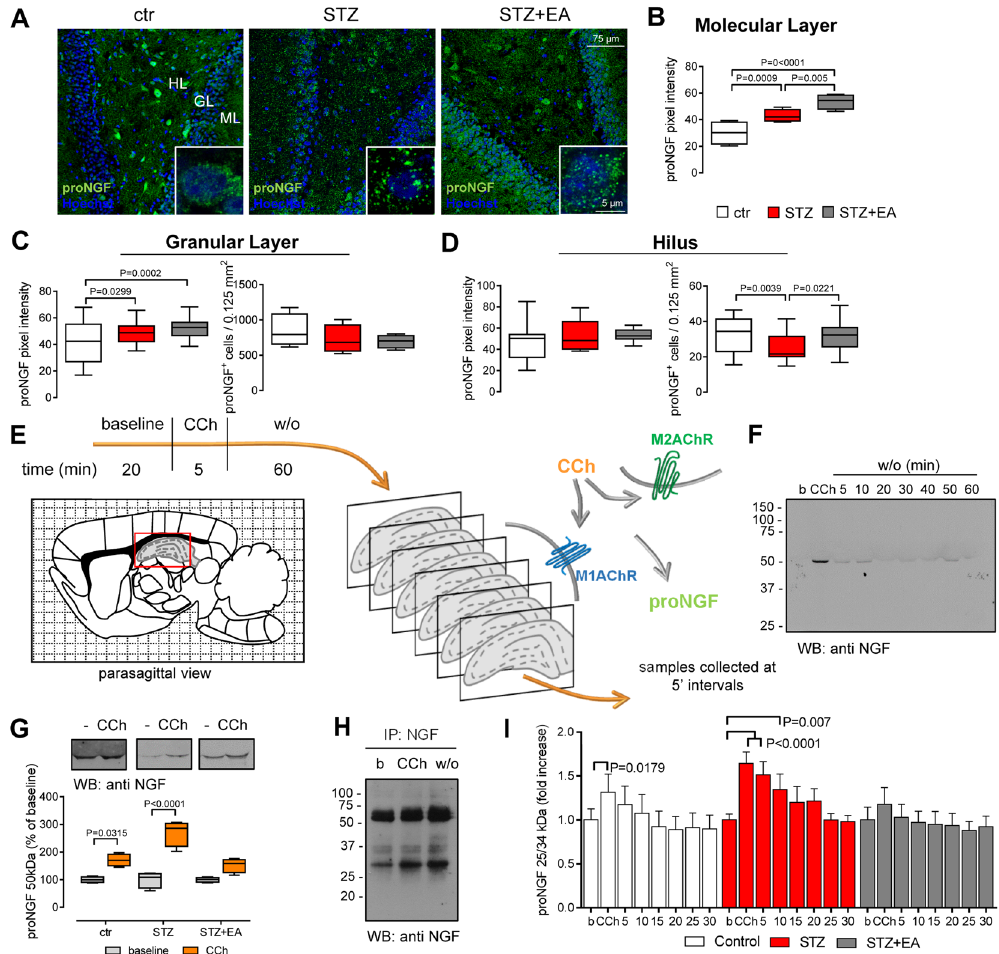
Figure 3. Diabetes and electroacupuncture treatment differentially modulate proNGF expression in the hippocampus. ( A ) Representative images of proNGF immunolocalization in the dentate gyrus (DG) of the hippocampus. Insets: Higher magnifications showing proNGF immunolocalization within DG granule cells. ( B–D ) Mean pixel intensity and the number of proNGF immunopositive (proNGF + ) cells in different areas of the DG (means ± SEM; n = 8 fields, 4 animals for each experimental group). One-way ANOVA followed by Bonferroni multiple comparison, P values shown in figure. ( E ) Cartoon depicting the experimental procedures performed in superfusion experiments and the possible carbachol (CCh) action on proNGF release by hippocampal cells. ( F ) Representative Western blot (WB) illustrating the time-course of carbachol-stimulated release of the 50 kDa proNGF from hippocampal slices of streptozotocin-treated rats. ( G ) Carbachol-stimulated proNGF release from hippocampal slices. Densitometry analysis of the WB (cropped representatives shown in the upper side of the panel; full-length blots are shown in online Supplementary material) illustrates the differences in carbachol-stimulated proNGF release among the different experimental groups. Data are expressed as percentage of the respective baselines (median ± interquartile range, whiskers: min. and max.). Two-way ANOVA followed by Bonferroni multiple comparisons, P values shown in figure. ( H ) WB of hippocampus superfusates after NGF-immunoprecipitation, revealing the presence of a 25 and a faint 34 kDa proNGF bands. ( I ) CCh-stimulated 25/34 kDa proNGF release from hippocampal slices measured by proNGF ELISA. Data (means ± SEM; n = 6 for each experimental group), represent the percentage of the respective baseline. Repeated-measure ANOVA followed by Bonferroni multiple comparison; P values shown in figure. Abbreviations: ML-molecular layer, GL-granular layer, HL-hilus, b-baseline,